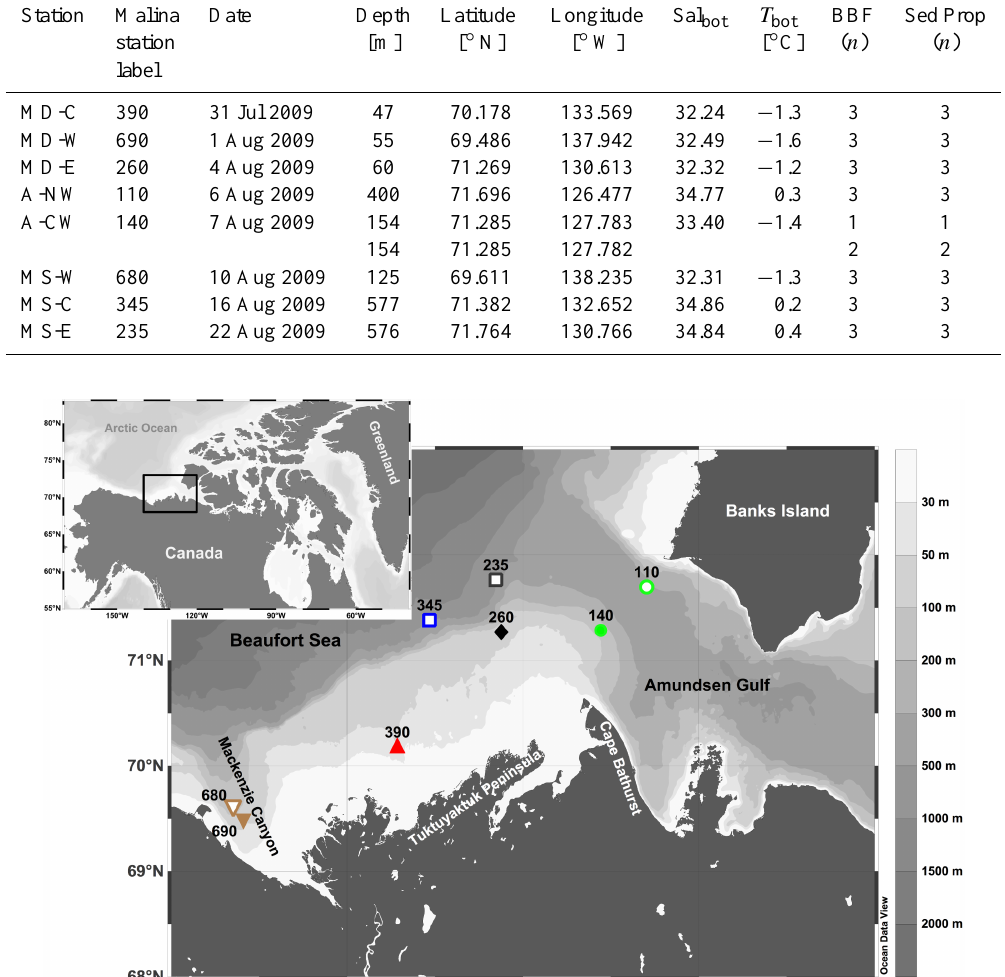
Table 1. Station list. Labels, date of sampling, geographic position, bottom water temperatures and salinities, number of within-station replicate samples used to determine benthic boundary fluxes (BBF) and sediment surface properties (Chl a , phaeopigments, porosity,